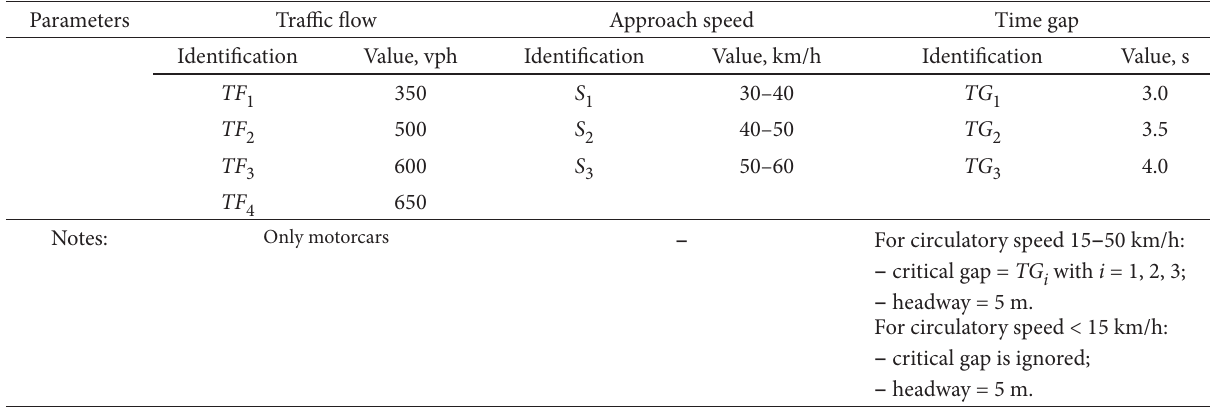
Table 1. Summary of the imposed values for traffic flow, approach speed and time gap